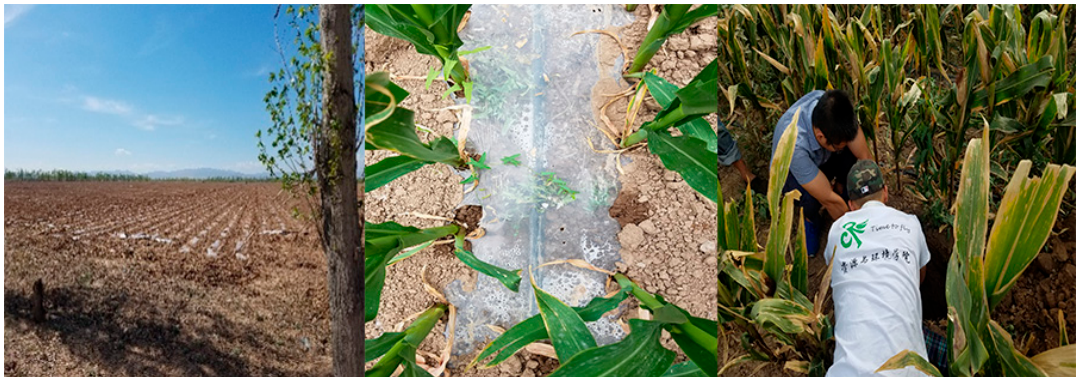
Figure 2. Study site layout and sampling status.